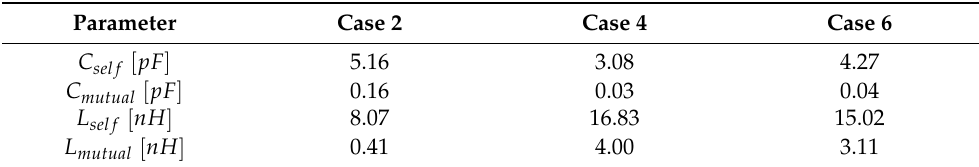
Table 3. Comparison of self- and mutual-capacitance and self- and mutual-inductance values at 20 GHz for cases 2, 4, and 6 extracted from Q3D